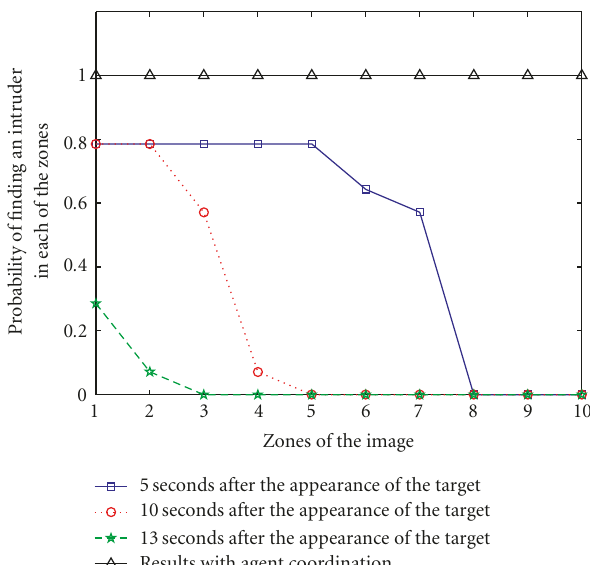
Figure 21: Probability of detecting a pedestrian in any of the zones into which the digital image is